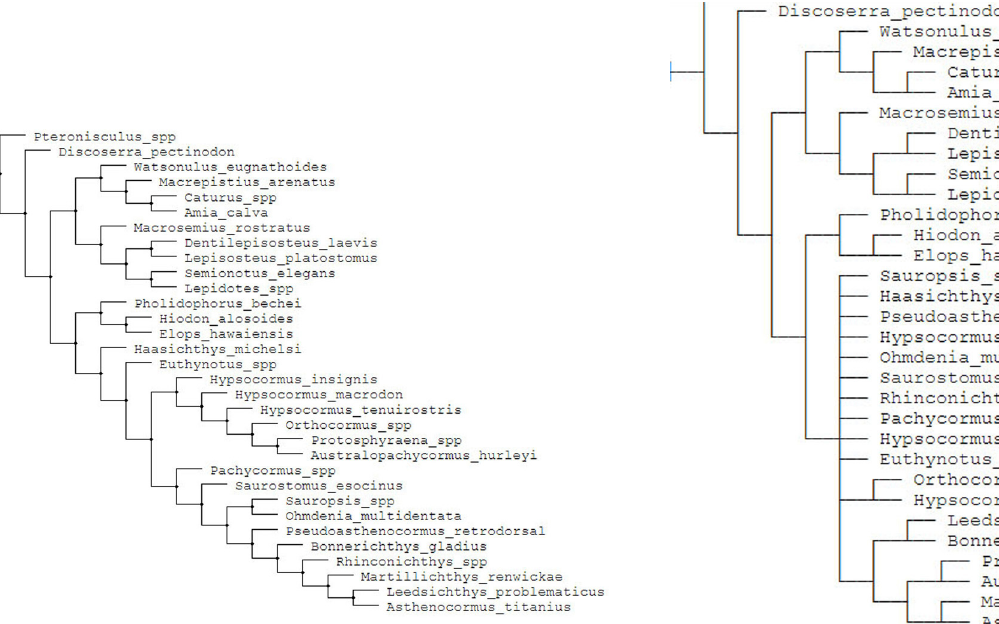
Figure 2. Strict consensus tree with ten dental characters removed (122 character, 32 taxon dataset). Note topograph- ic shift of Australopachycormus and Protosphyraena into the suspension-feeding